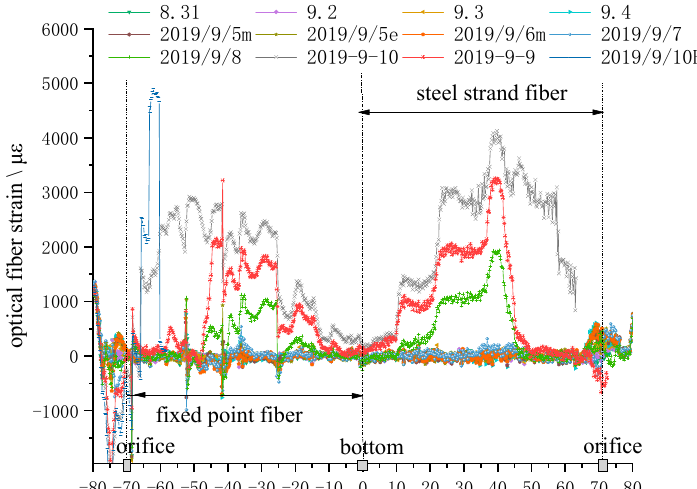
Figure 26. Strain curve of optical fiber of monitoring line ② .